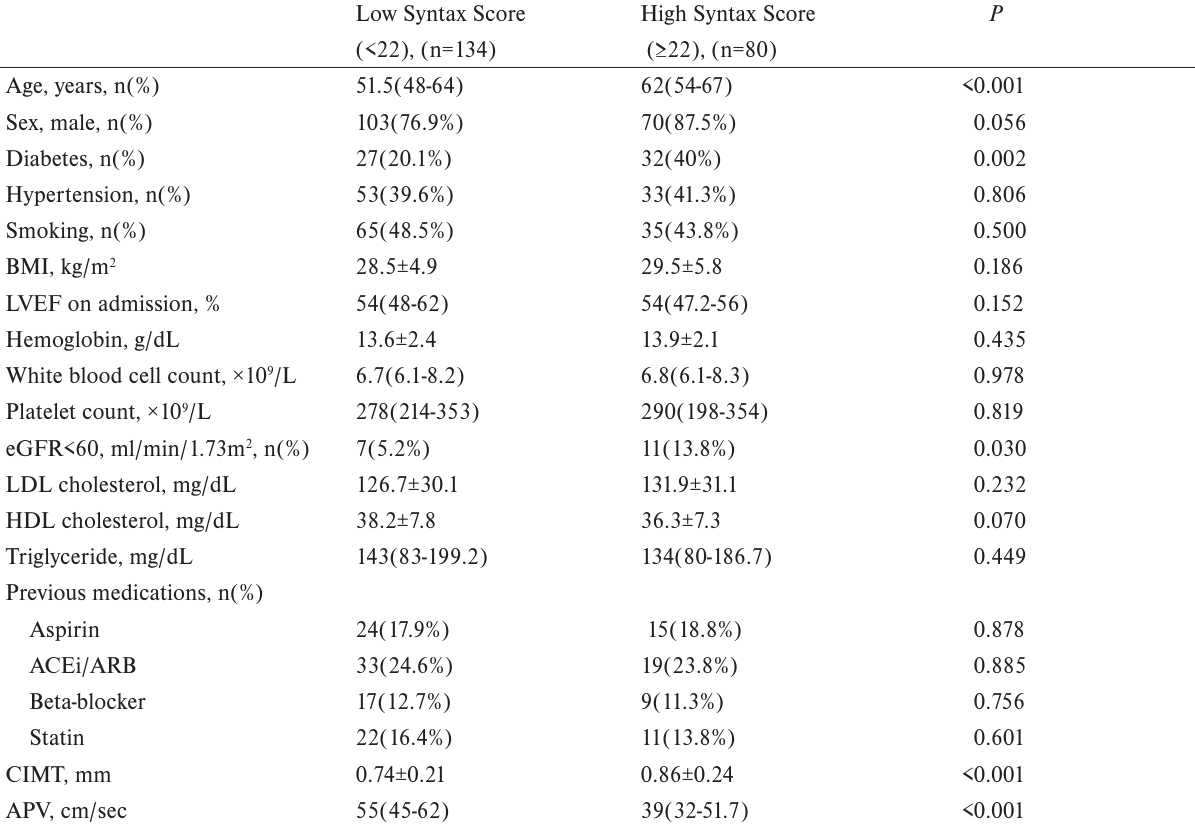
Table 1. Clinical and Demographic information of subjects with low and high SYNTAX Scores Low Syntax Score High Syntax